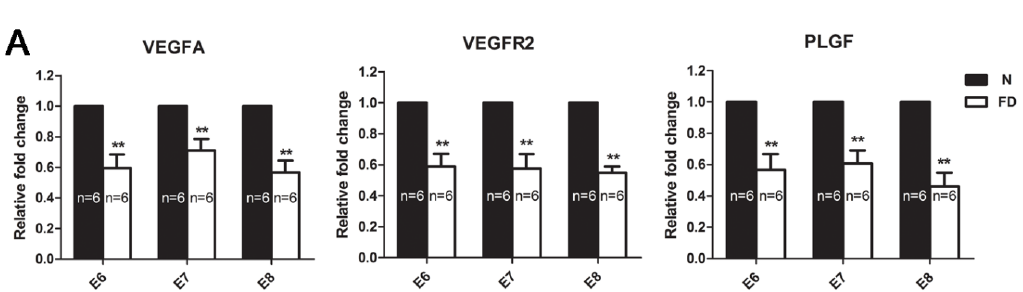
Figure 4. Figure 4. Cont. Figure 4. Cont.